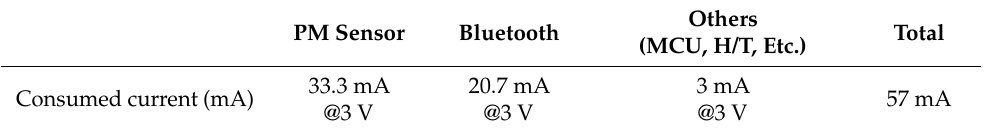
Figure 16. Power consumption and GUI of the smartphone: ( a ) environment for power consumption measurement ( b ) Smartphone GUI. Table 4. Power consumption of the